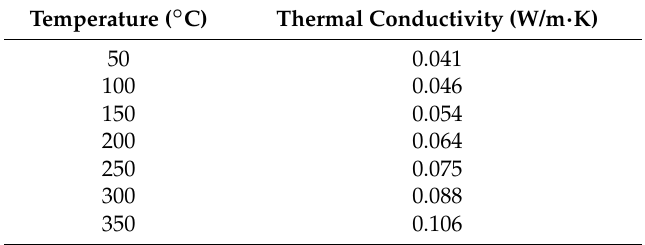
Table A2. Thermal conductivity of the thermal insulation studied (Rockwool ProRox PSM 971, 50 mm)